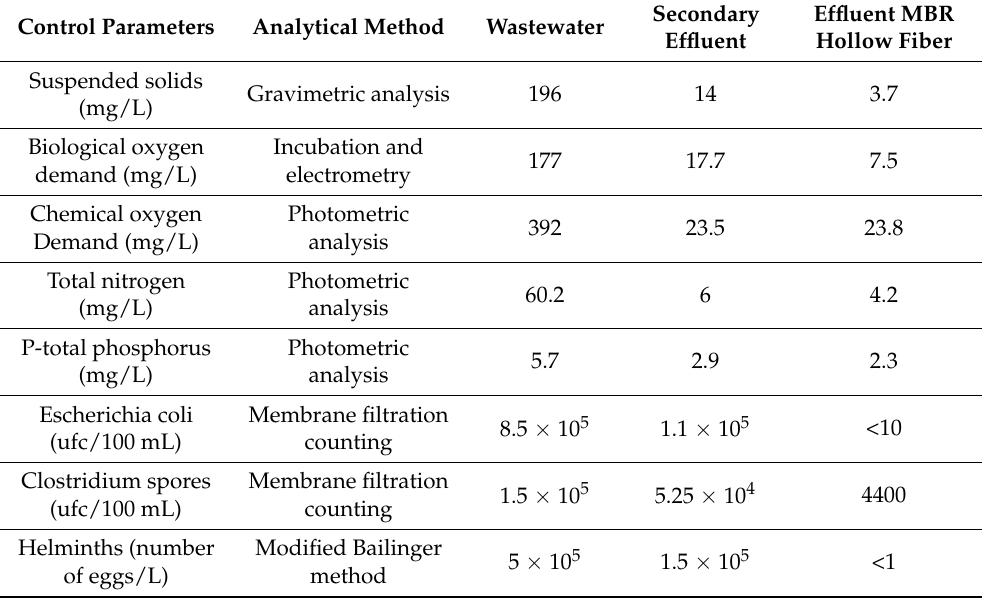
Table 2. Average concentrations of the usual parameters for treatment monitoring at WWTP A.